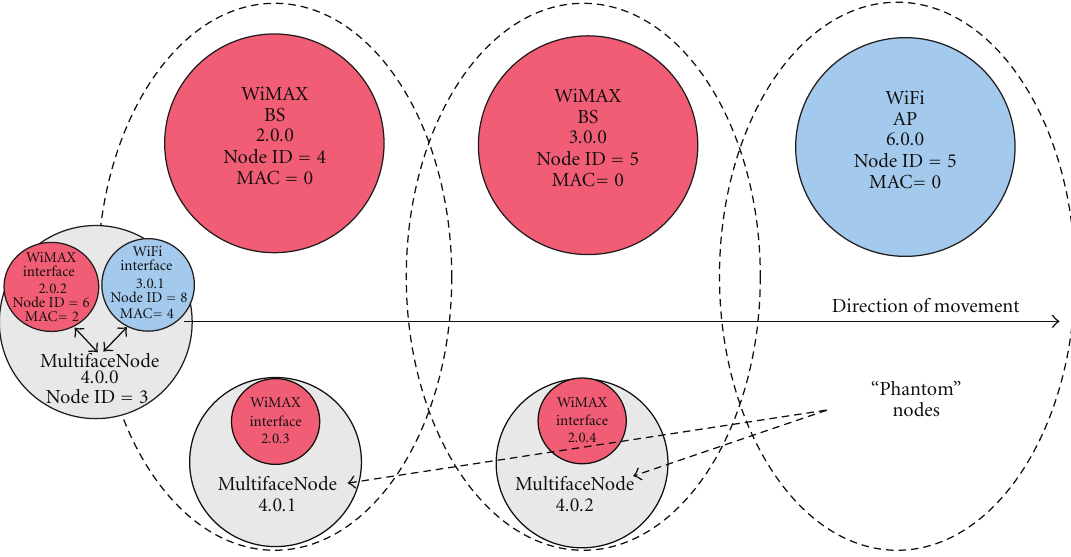
Figure 4: “Phantom nodes” in WiMAX simulation.